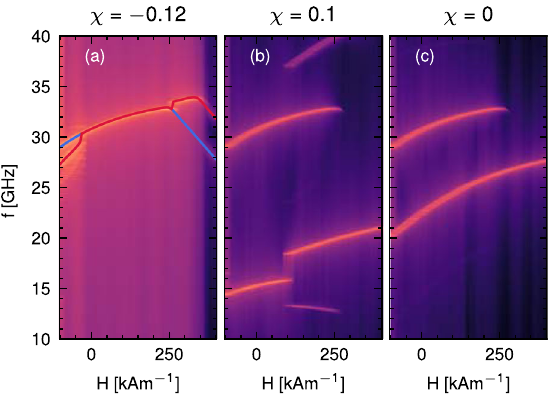
Fig. 8 The electric synchronisation of two MTJs. Electric coupling constant was set to χ = − 0.12 ( a ) and χ = 0.1 ( b ). Solid blue and red lines in ( a ) indicate the primary resonance modes of individual MTJs from the stack. c Shows the same device with no coupling